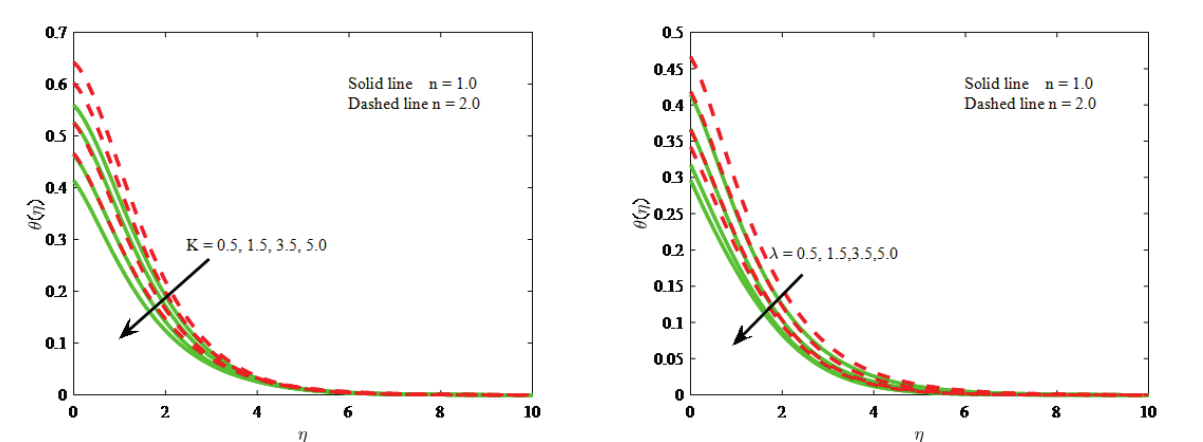
Fig. 10: Impact of λ on temperature.